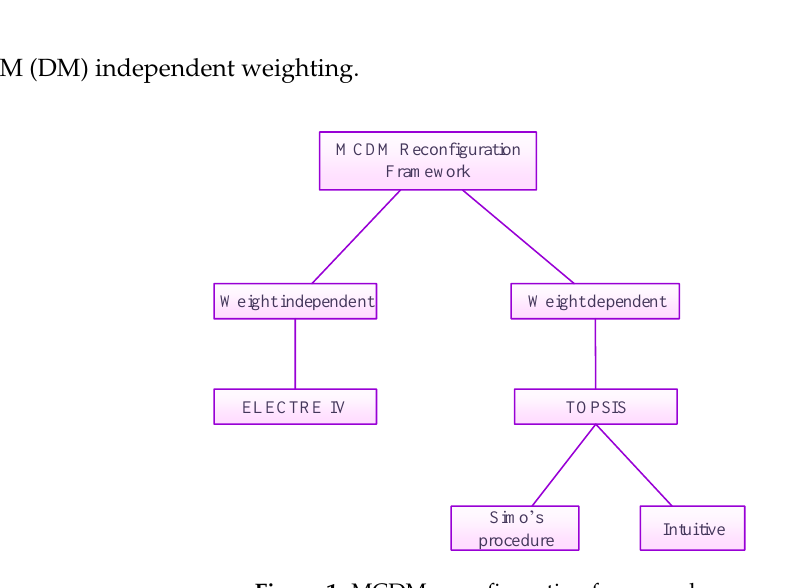
Figure 1. MCDM reconfiguration framework.